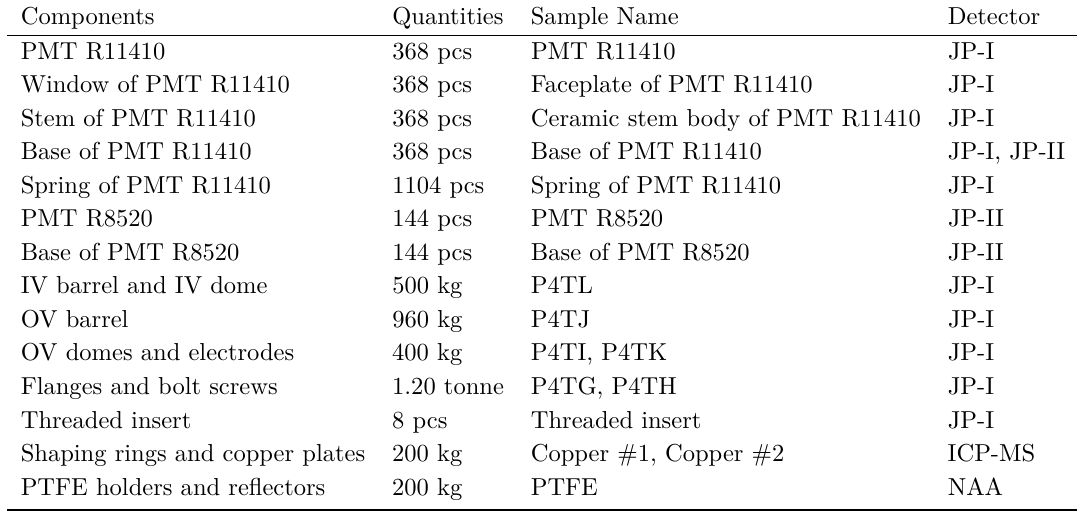
Table 1. Sample materials used in PandaX-4T